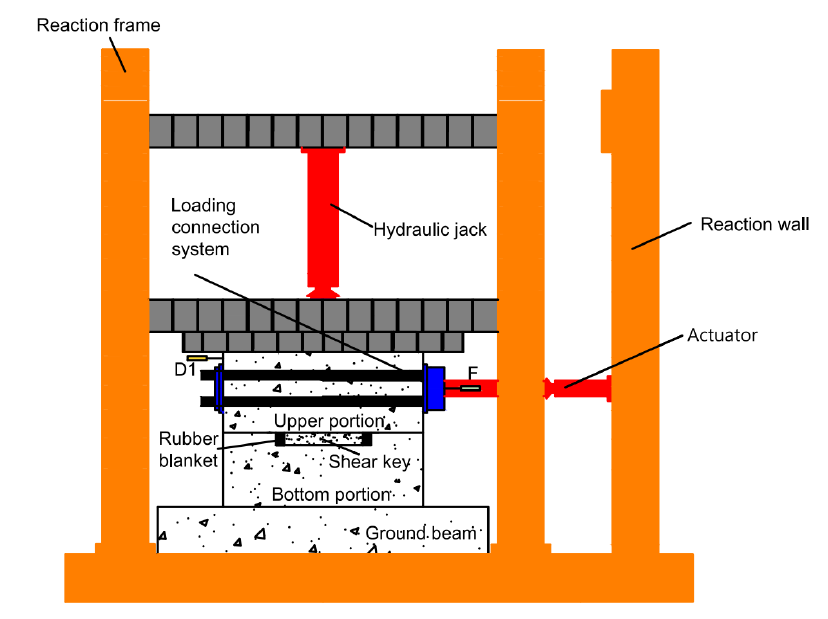
Figure 6. Setup for the tests.